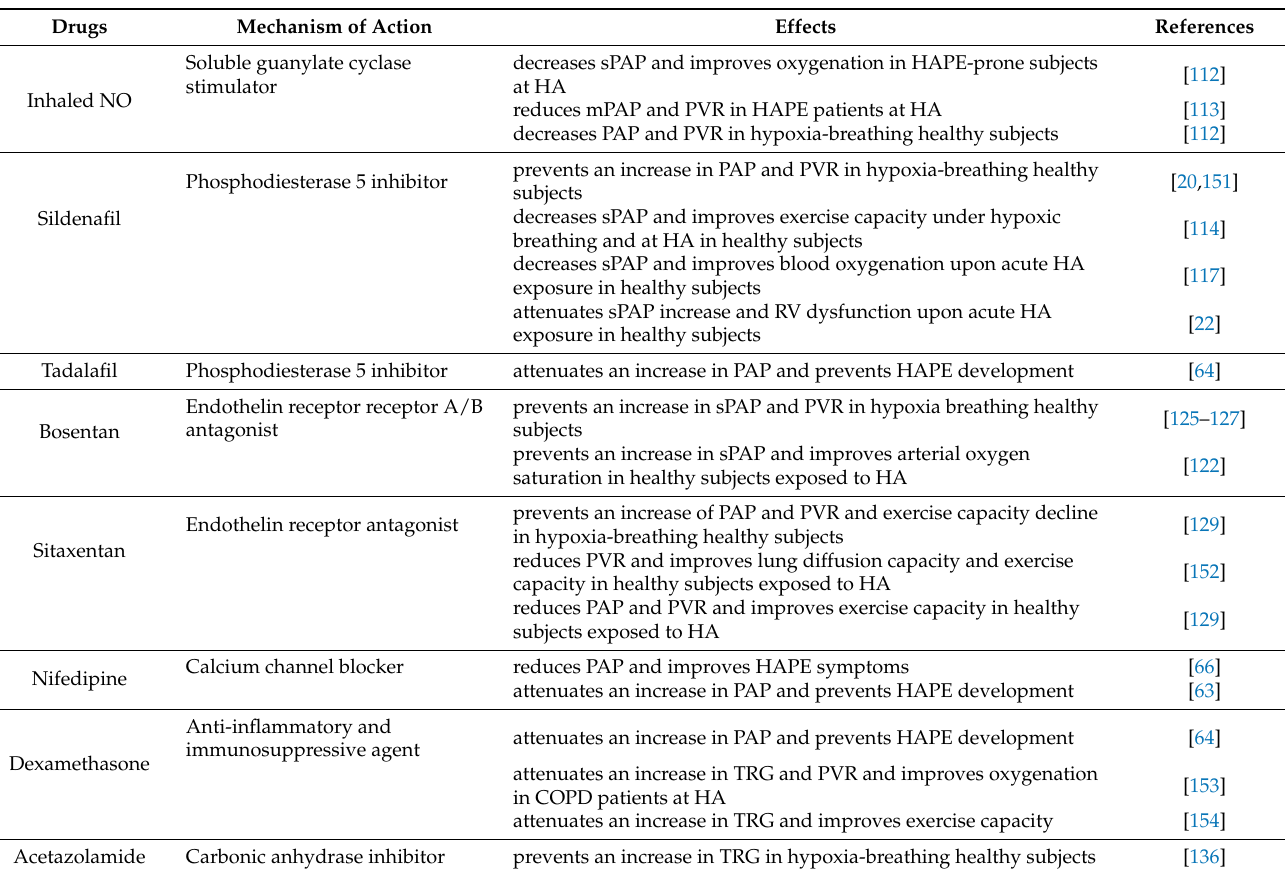
Table 2. Summary of relevant studies evaluating effects of potential drugs on HPV in healthy human subjects exposed to